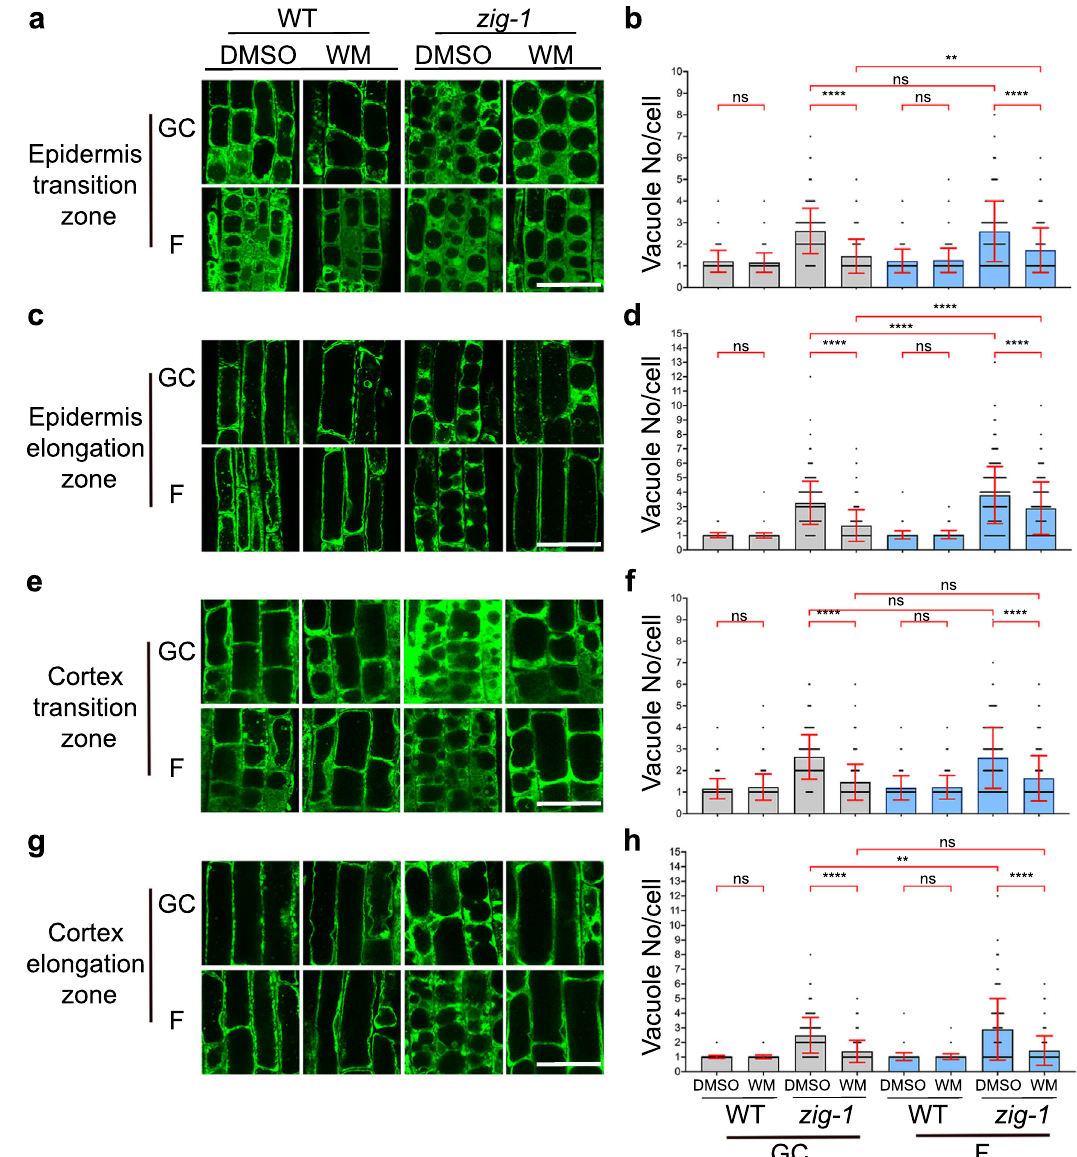
Fig. 4 Quanti fi cation of WM-induced vacuole fusion. Vacuole morphology ( a , c , e , g ) and vacuole number ( b , d , f , h ) of WT and zig-1 plants expressing GFP-TIP2;1. Seedlings were grown in ground control or the ISS and treated with DMSO buffer (control) or WM solution. Cells were imaged at the root tip epidermis transition zone ( a , b ), epidermis elongation zone ( c , d ), cortex transition zone ( e , f ) or cortex elongation zone ( g , h ). Four-day-old seedlings were treated with DMSO buffer control or WM solution for 2 h and then seedlings were fi xed and kept in 4 °C before confocal imaging. (Three-way ANOVA, Tukey ’ s multiple comparison test, **** p < 0.0001; ** p < 0.0021; n represents cell number under analysis per genotype per treatment, n > 155). Raw datapoints are represented with fi lled circles. Error bars represent standard deviation. Scale bar: 40 μ